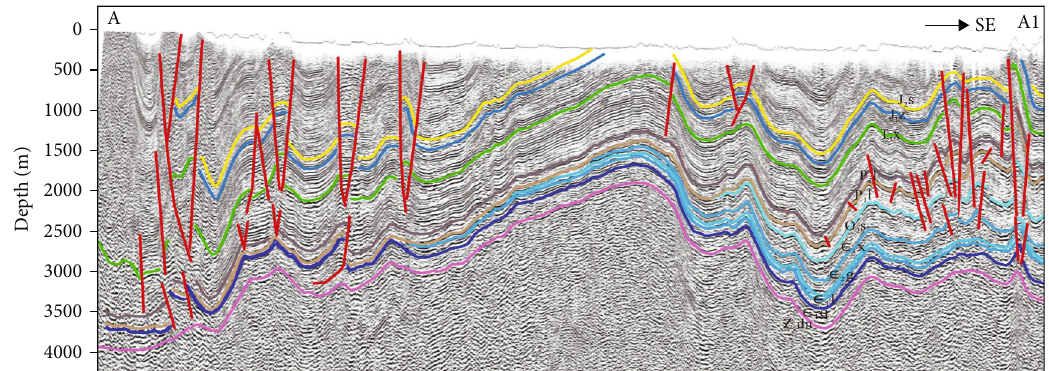
Figure 2: Seismic interpretation pro fi le of the Zhougong Mountain-Weiyuan structure in southwestern Sichuan Basin.